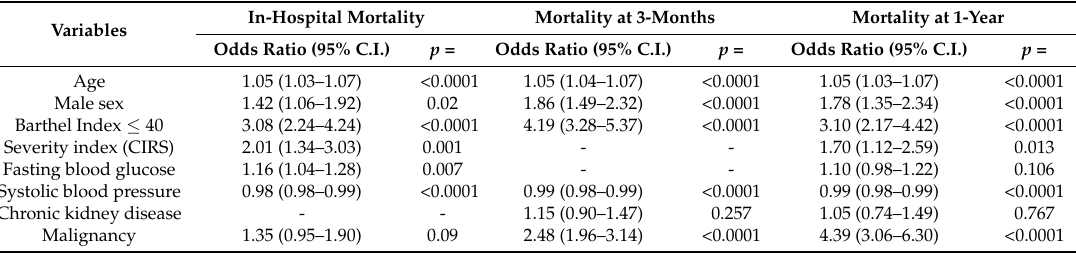
Table 2. Multivariate analyses according to in-hospital, 3-month, and 1-year mortalities in all population.